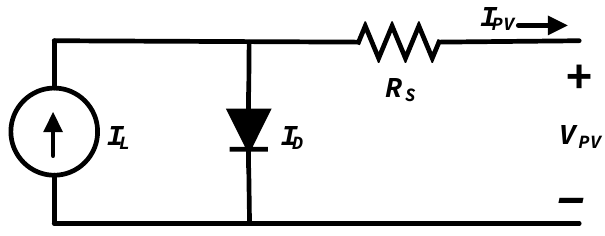
Figure 3. Simplified-photovoltaic (PV) model.